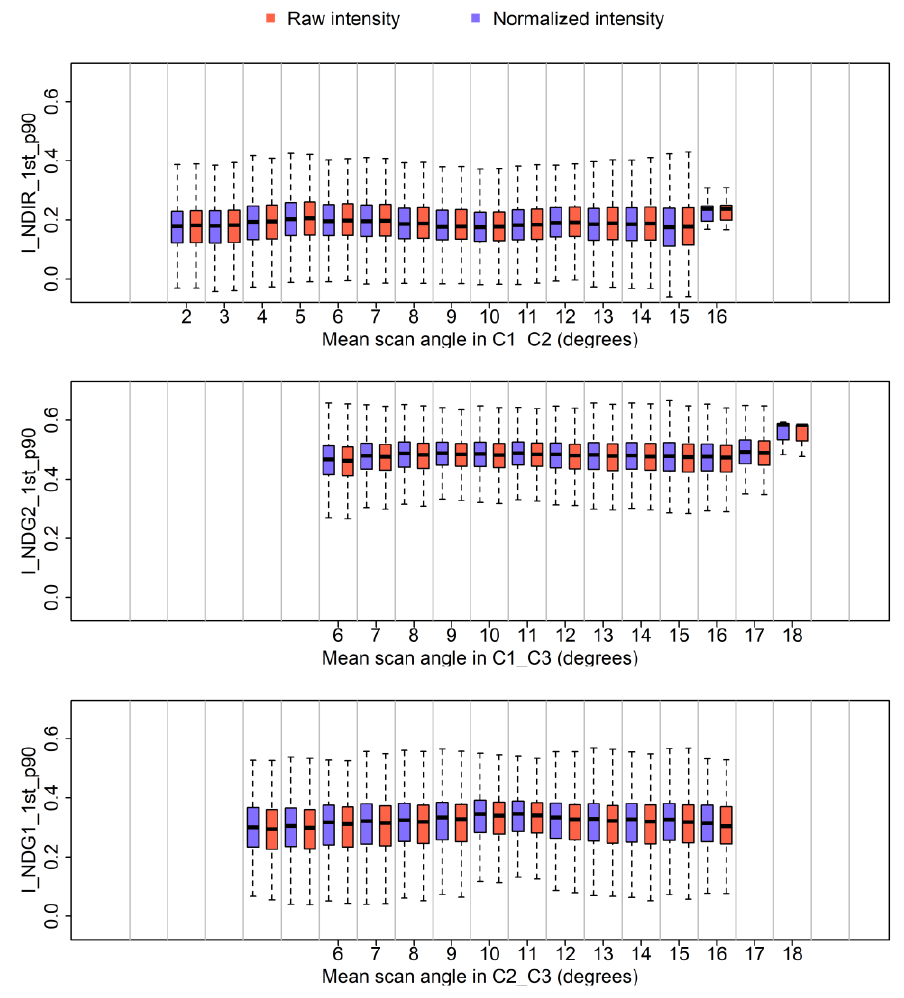
Figure 8. Normalized vegetation indices computed from raw and normalized intensity values of the 90th percentiles of first returns as a function of mean scan angle. Table 4. Number and percentage of cases having a correlation ( r ) greater than |±0.2| between mean scan angle and feature values.